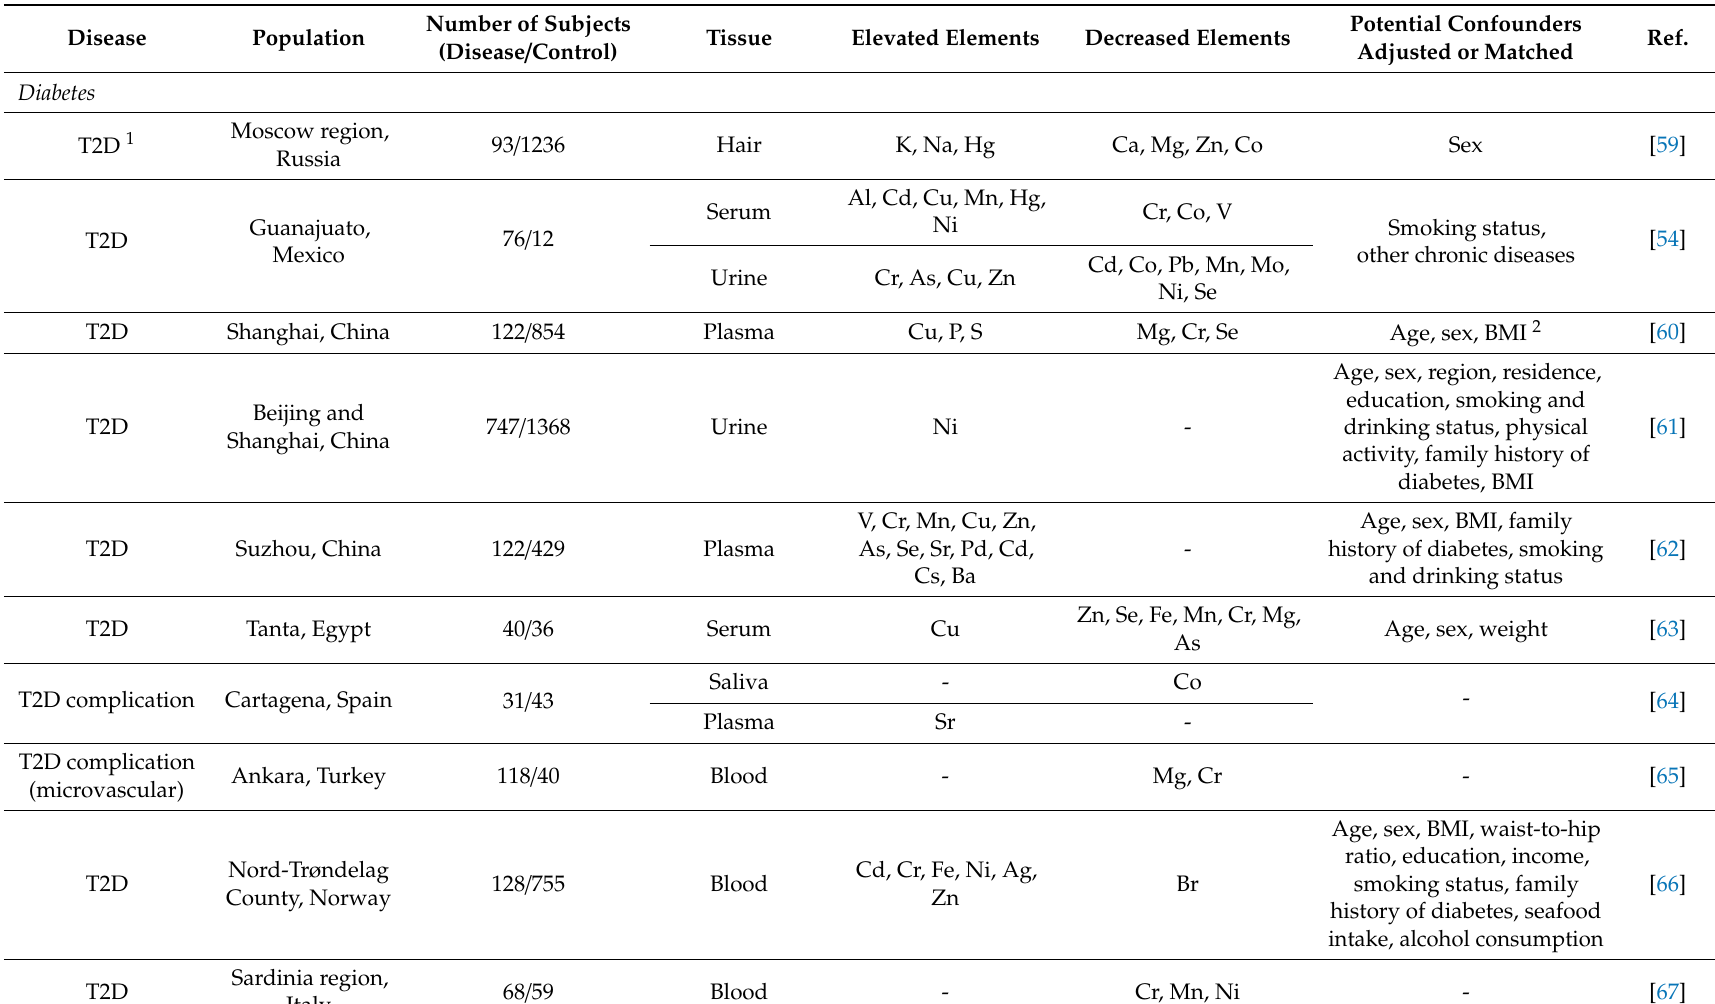
Table 1. Major ionomic results for complex